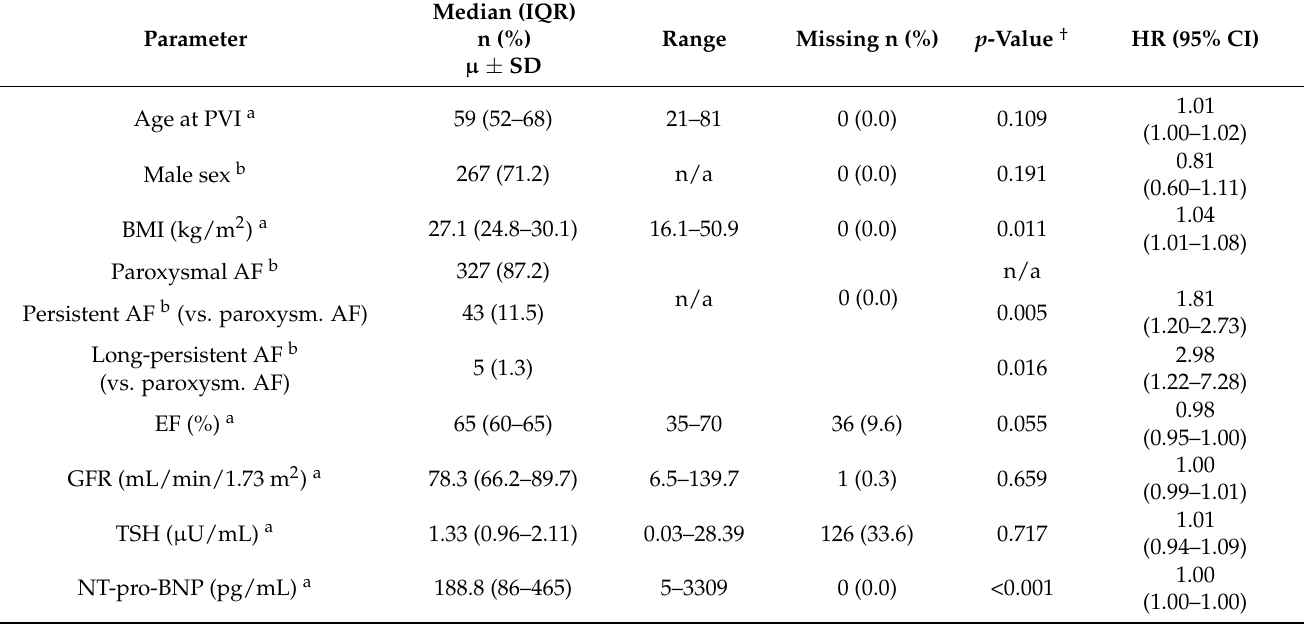
Table 1. Baseline characteristics of the cryo-PVI cohort (n =